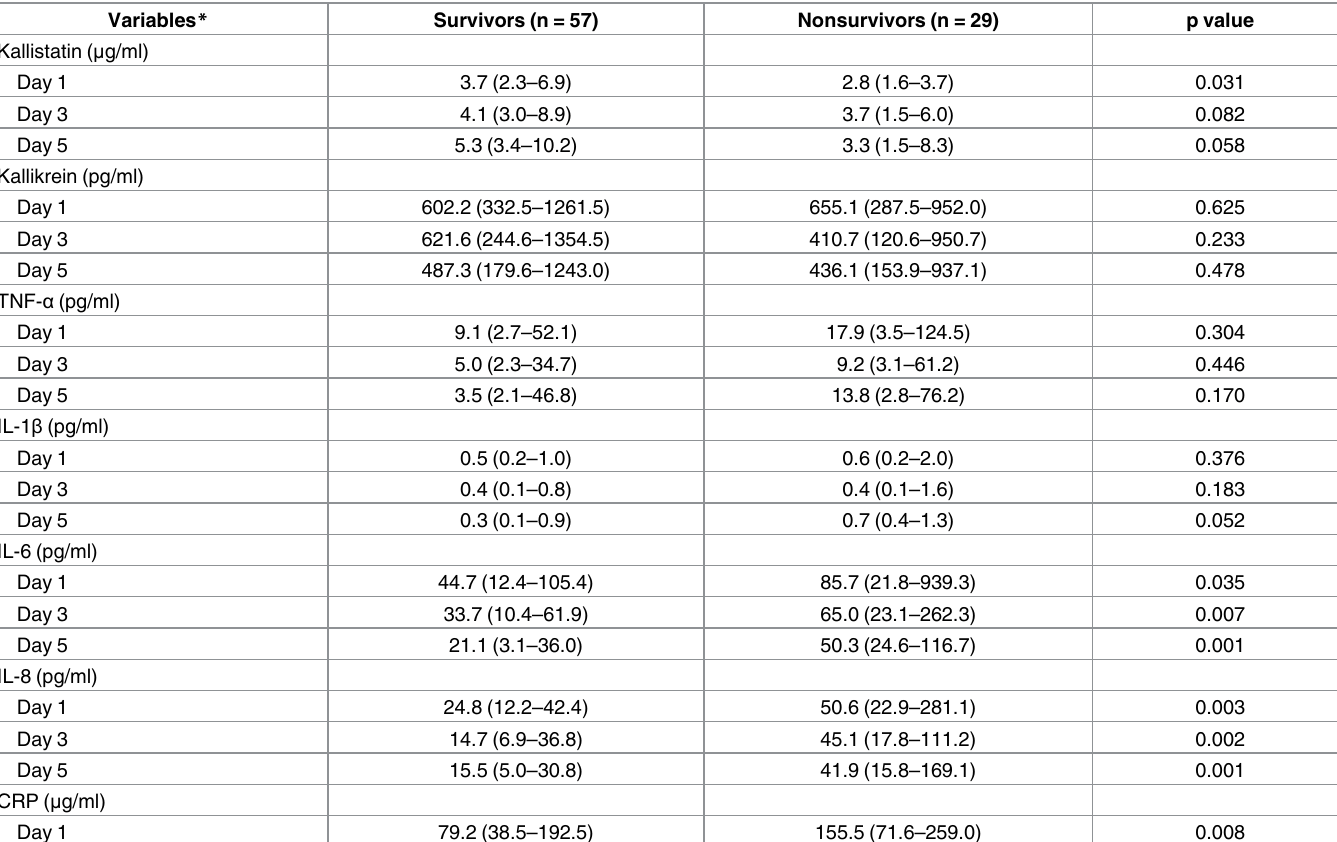
Table 3. Comparisons of plasma biomarkers between survivorsand nonsurvivors of severesepsis and septic shock. Variables